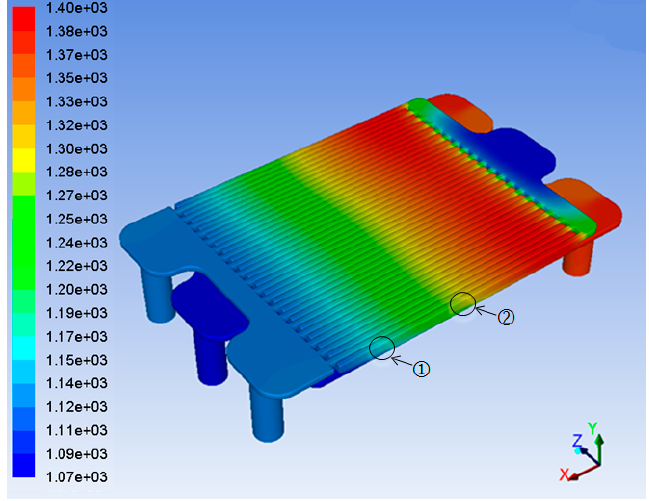
Figure 7. Temperature distributions within the one-cell SOFC stack with interdigitated fuel flow channels. (note: e-01 in the figure means × 10 − 1 ).